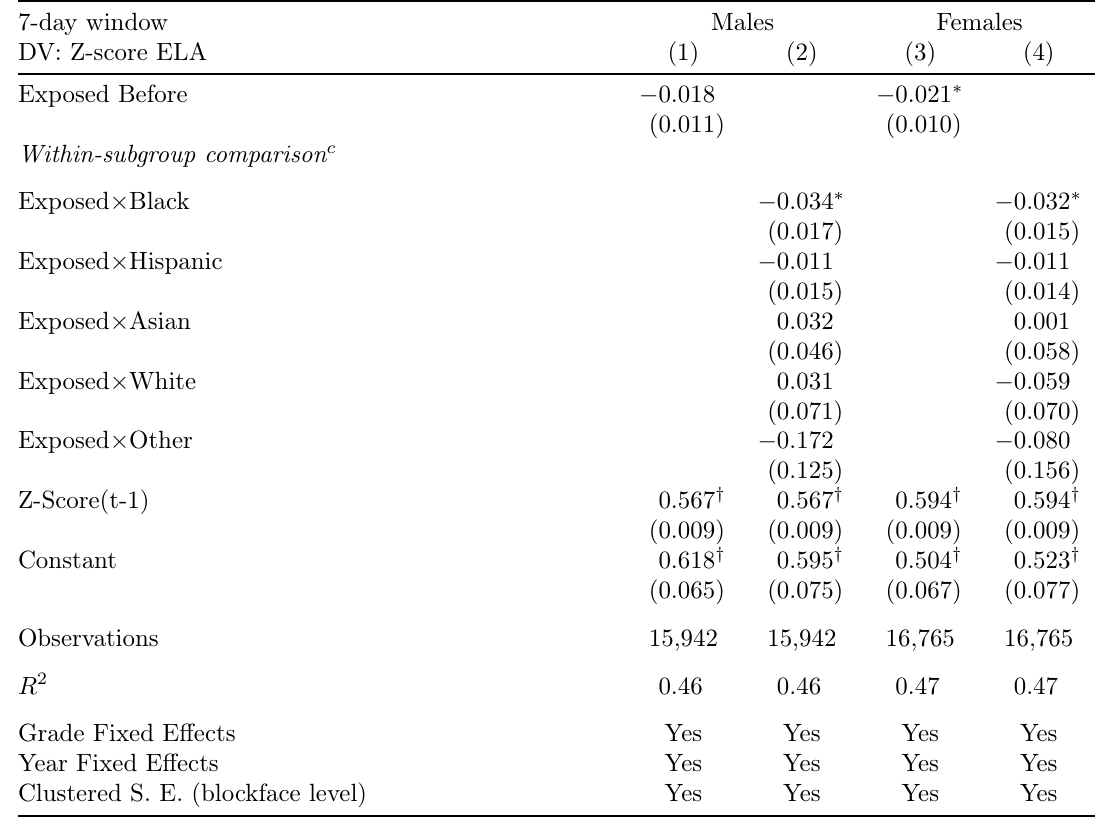
Table 4: Gender Models (School Years 2004/2005 to 2009/2010): Impact of Exposure to Violent Crime a and in a High-Poverty Sample